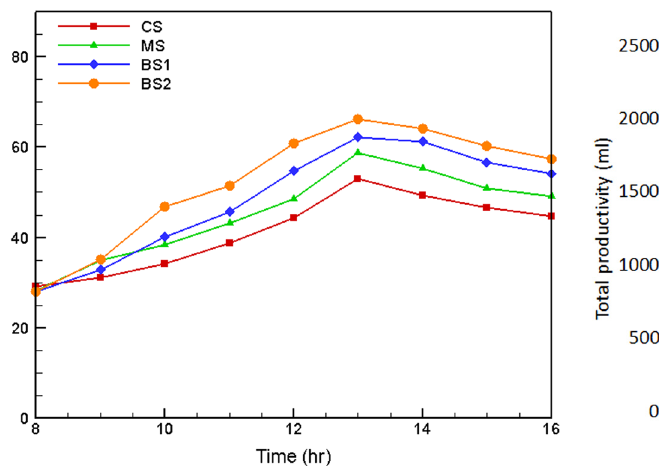
Figure 12: Variation of condenser outside surface temperatures with time.